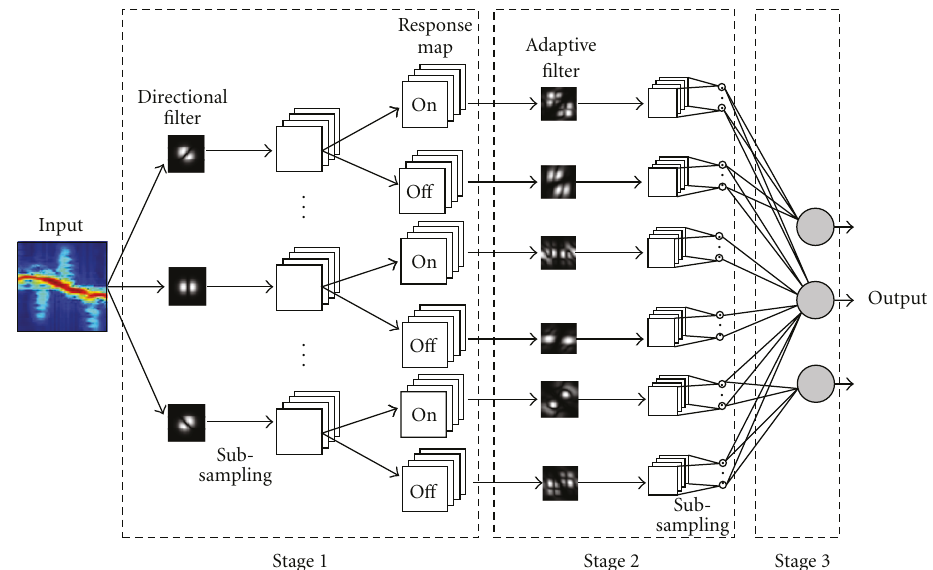
Figure 2: The hierarchical image classification